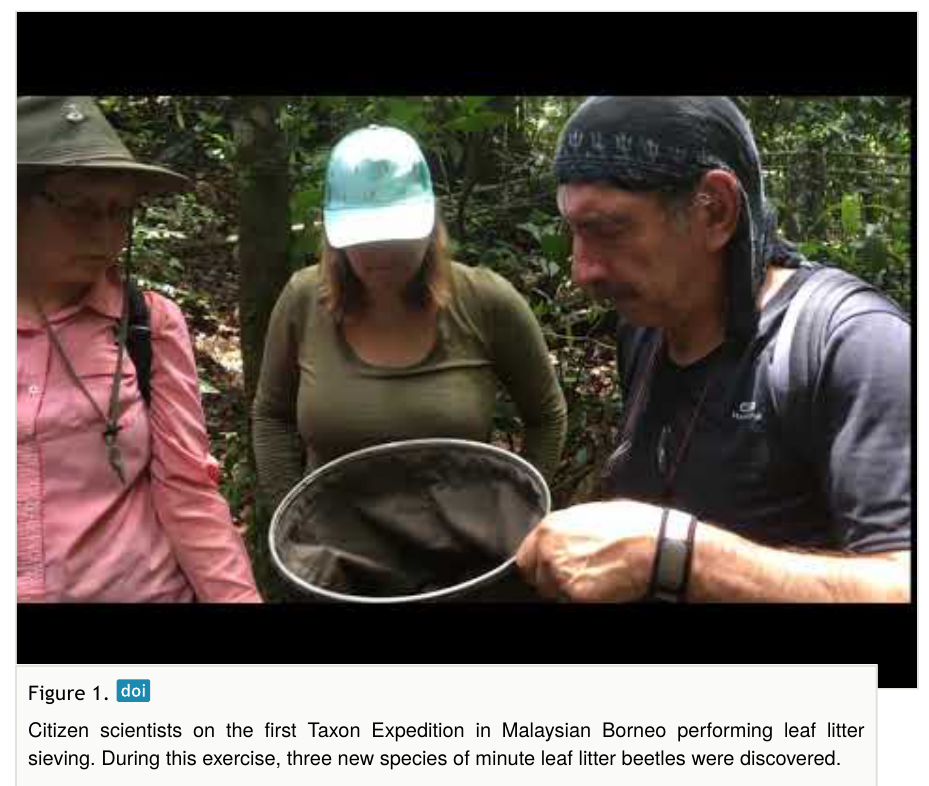
Colenisia Fauvel and 2 specimens of Dermatohomoeus Hlisnikovský (Leiodinae: Pseudoliodini) were found. The fl oor sample yielded no materials from these